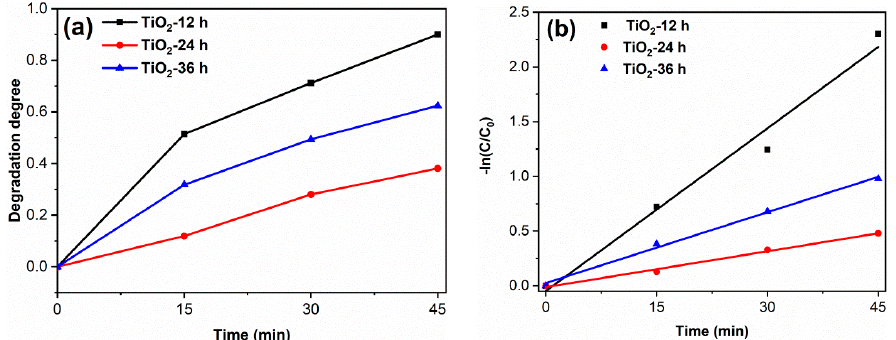
Figure 8. The TC degradation curves ( a ) and the kinetics fitting curves ( b ) of samples. (catalyst 0.1 g, TC solution 100 mL